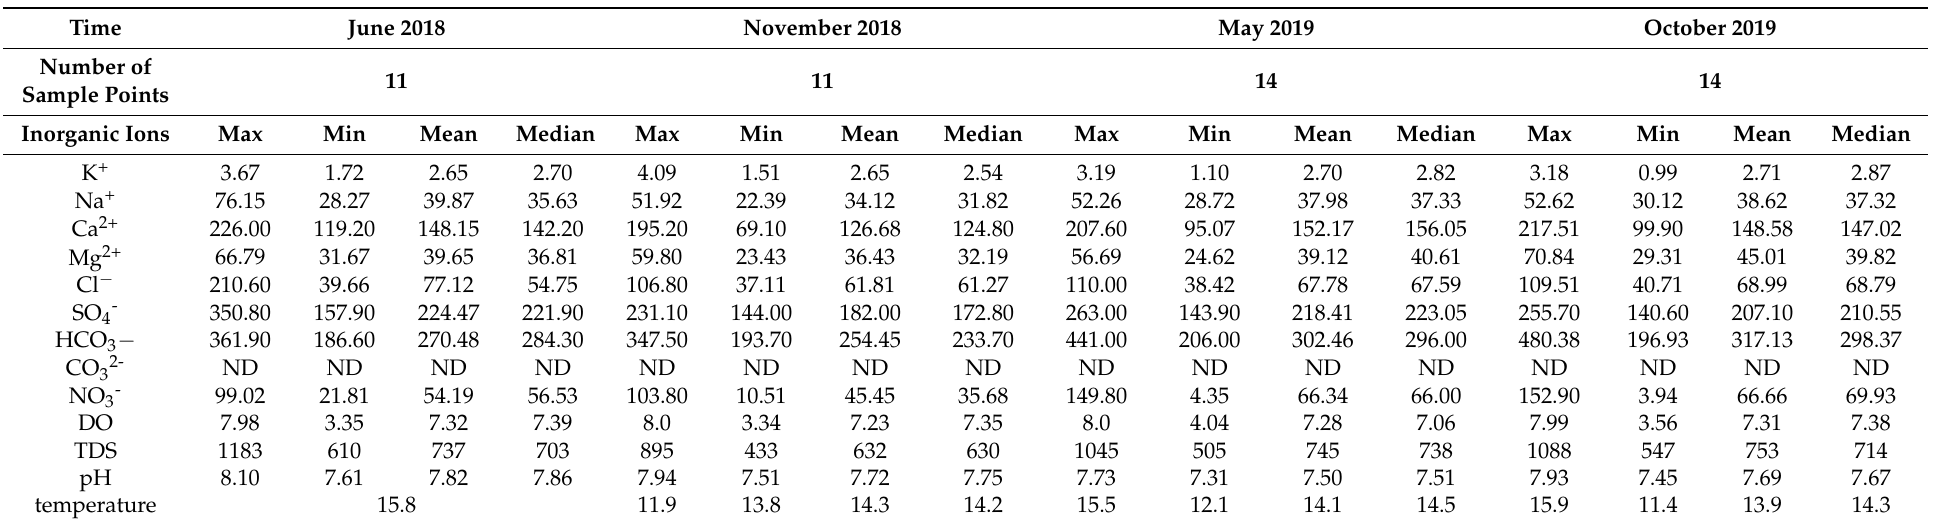
Table 1. Concentrations of Inorganic Ions of Samples